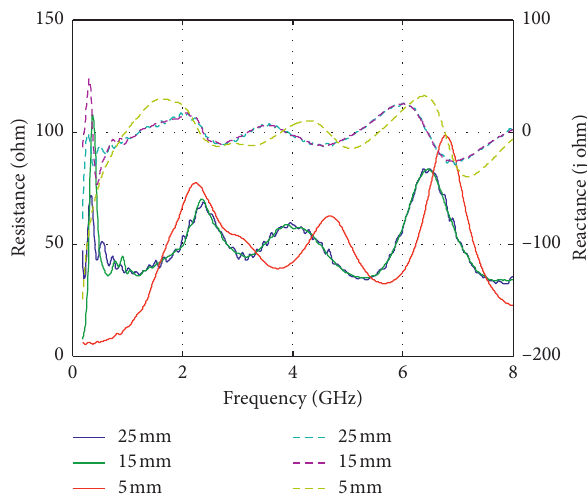
Figure 13: Simulated input impedance of antennas with different disc ground radii.